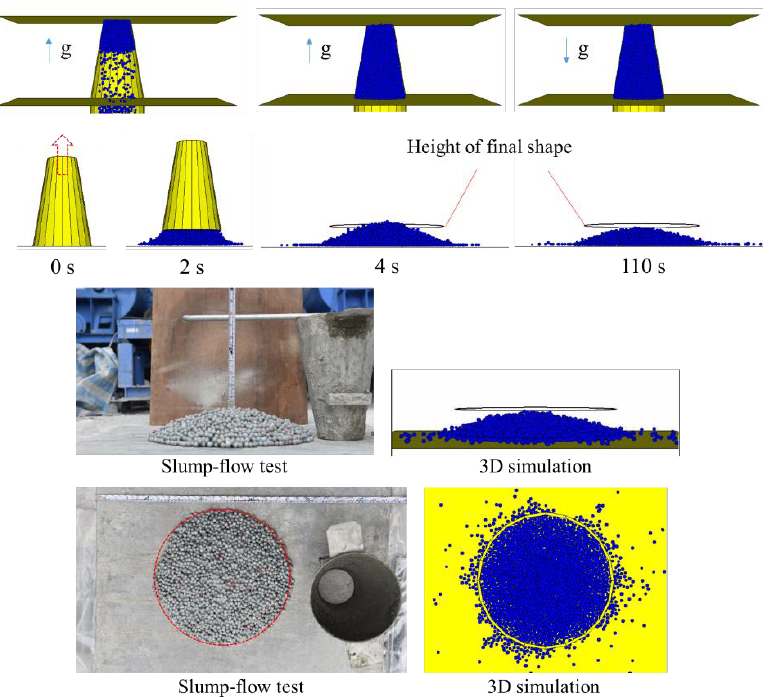
Figure 7. Results of slump–flow test and numerical simulation.